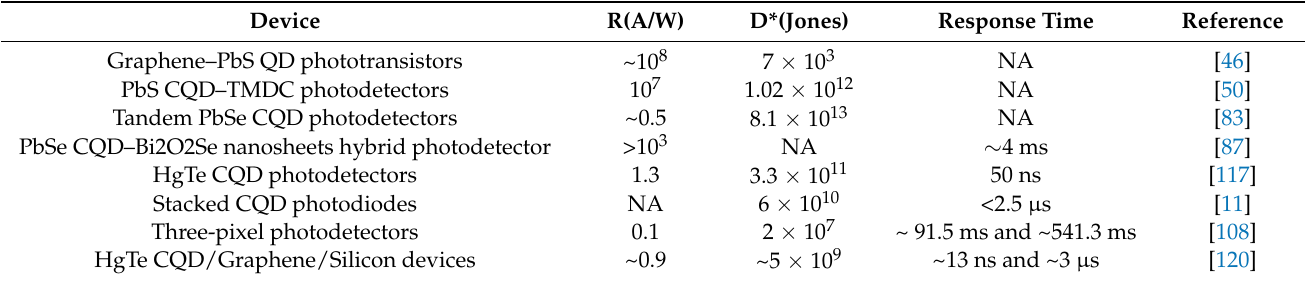
Table 1. Performance comparison of several representative